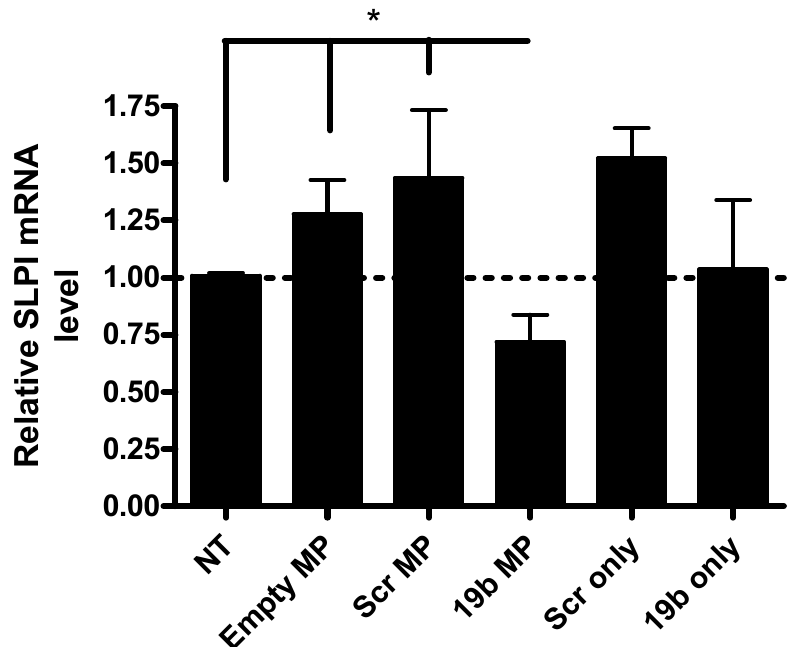
The effects of PLGA microparticle formulations on the expression of SLPI in PMA-differentiated U937 macrophages post transfection, as determined by qRT-PCR. Cells were left untreated (NT) or treated, in triplicate, with empty (no RNA), scrambled control (Scr) or pre-miR19b (19b)-containing PLGA microparticles (MP) at an RNA concentration of 30 nM. Cells were also treated with scrambled control (Scr) or pre-miR19b alone (only). Cells were washed and media was replaced after three hours and cells were lysed 72 h post transfection. Results (mean + SEM) are normalised to GAPDH expression; data are representative of three experiments. NT: non-transfected. * p ≤ 0.05; one-tailed t test, compared to 19b MP.